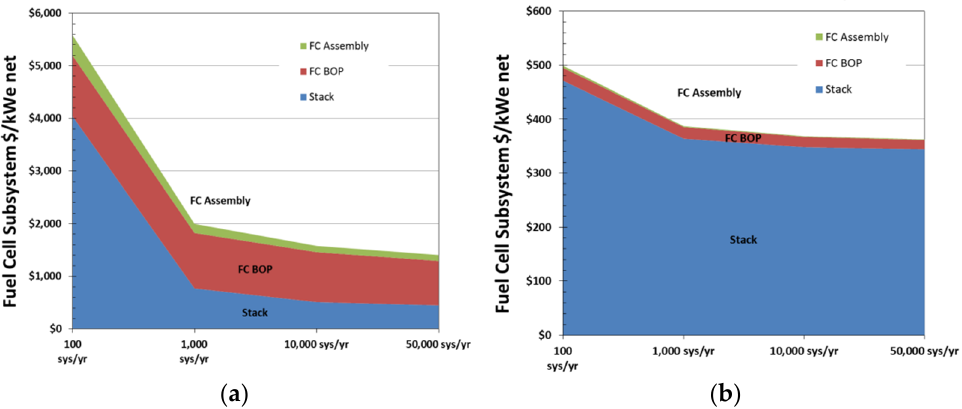
Figure 9. Cost prediction and analysis for SOFC subsystem ( a ) 1 kWe Fuel Cell SOFC Subsystem; ( b ) 100 kWe Fuel Cell SOFC Subsystem [94]. ( b ) 100 kWe Fuel Cell SOFC Subsystem